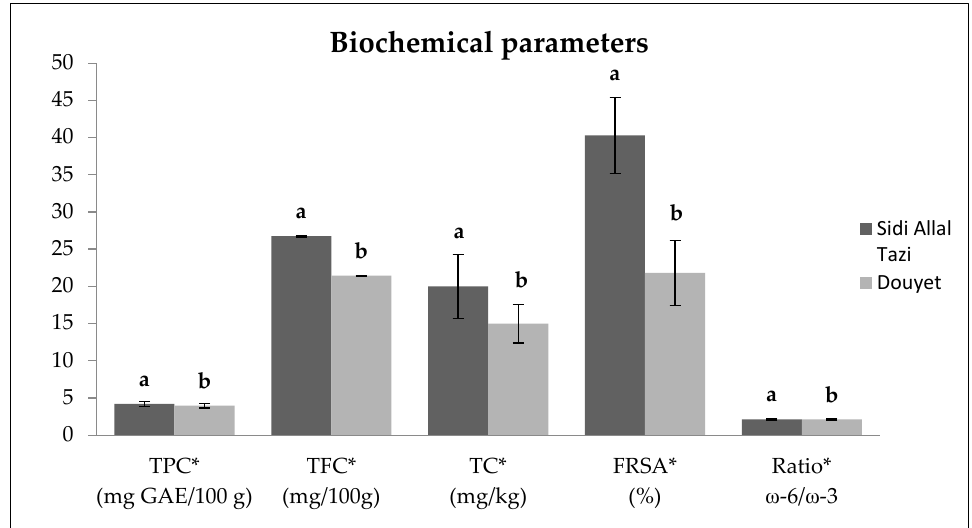
Figure 2. Biochemical parameters variation according to the growing environment of the six Moroccan rapeseed cultivars experimented. * Total phenolic content (TPC), total flavonoid content (TFC), total carotenoid content (TC), free-radical scavenging activity (FRSA), omega 6/omega 3 ratio (ratio ω -6/ ω -3). Different superscript letters, for each parameter, indicate significant difference between the two environments, Sidi Allal Tazi and Douyet, at p < 0.05 according to Duncan’s multiple range test.